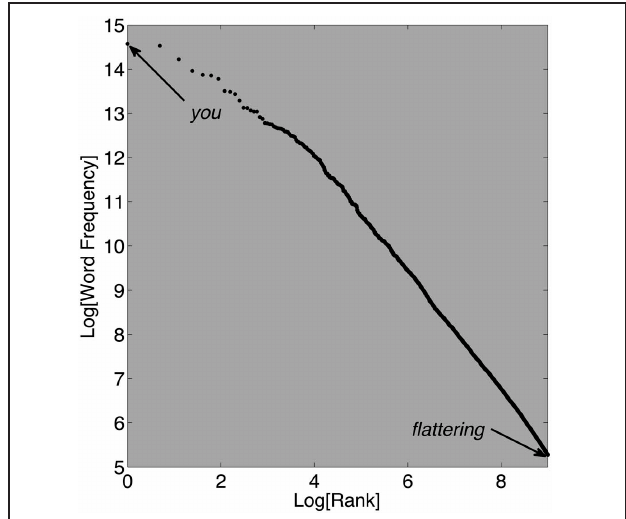
FIGURE 5 | This plot depicts the Zipf’s Law relation between the frequency of occurrence of words in the SUBTLEX US database and the usage rank for approximately 8000 of the most common words (Brysbaert and New, 2009). The SUBTLEX US database is based on a total of 51 million words that were made available as part of the Elexicon project ( http://elexicon . wustl . edu/ ). Displayed on log-log axes, the rank-frequency relation approximates a straight line, indicating a power